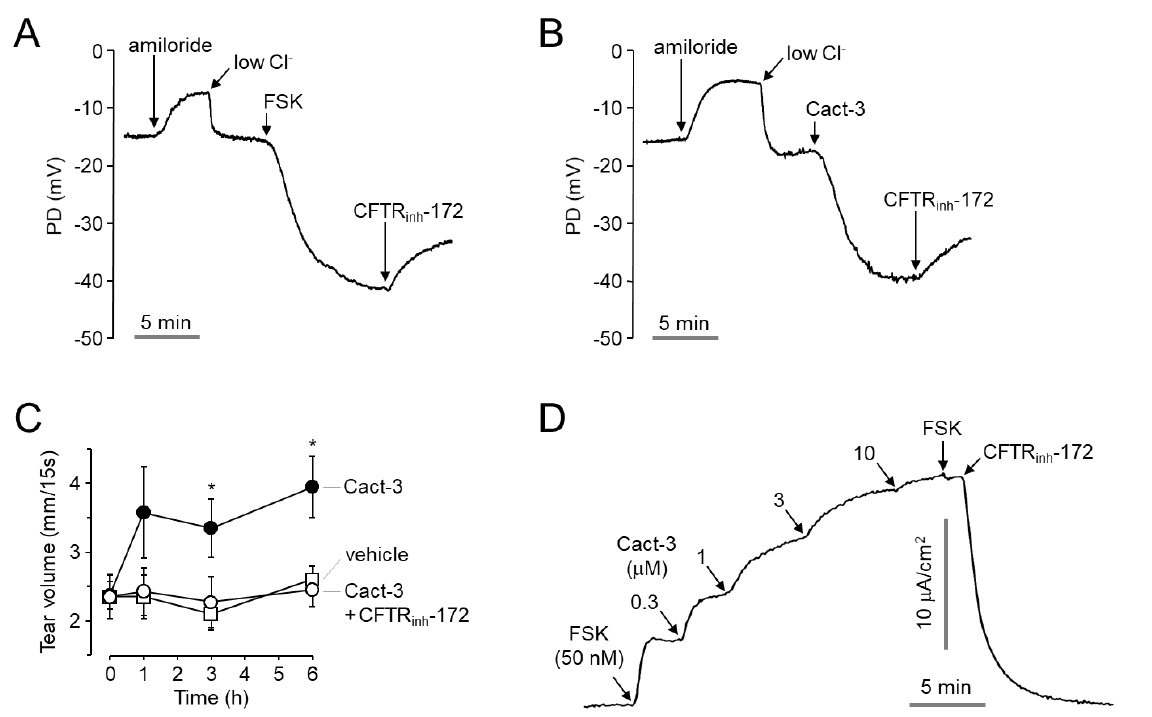
Figure 4. Effect of Cact-3 on mouse ocular surface PD and tear volume, and CFTR activity in primary cultured human conjunctival epithelial cells. ( A , B ) Representative traces of ocular surface open-circuit PD measurements. PD was measured in response to perfusion with solutions containing indicated compounds (100 μM amiloride, 20 μM forskolin, 30 μM Cact -3, and 20 μM CFTR inh -172). ( C ) Tear volume was measured using phenol red thread test at the indicated times after 2.5 µ L of single ocular delivery of a vehicle, Cact-3 (100 µM) and CFTR inh -172 (20 µM), in mice (mean ± S.E., n = 5). ( D ) Representative trace of short circuit current in primary cultured human conjunctival epithelial cells. CFTR was weakly activated by 50 nM, enhanced by the indicated concentrations of Cact-3, and inhibited by 10 μ M CFTR inh -172. * p < 0.05.